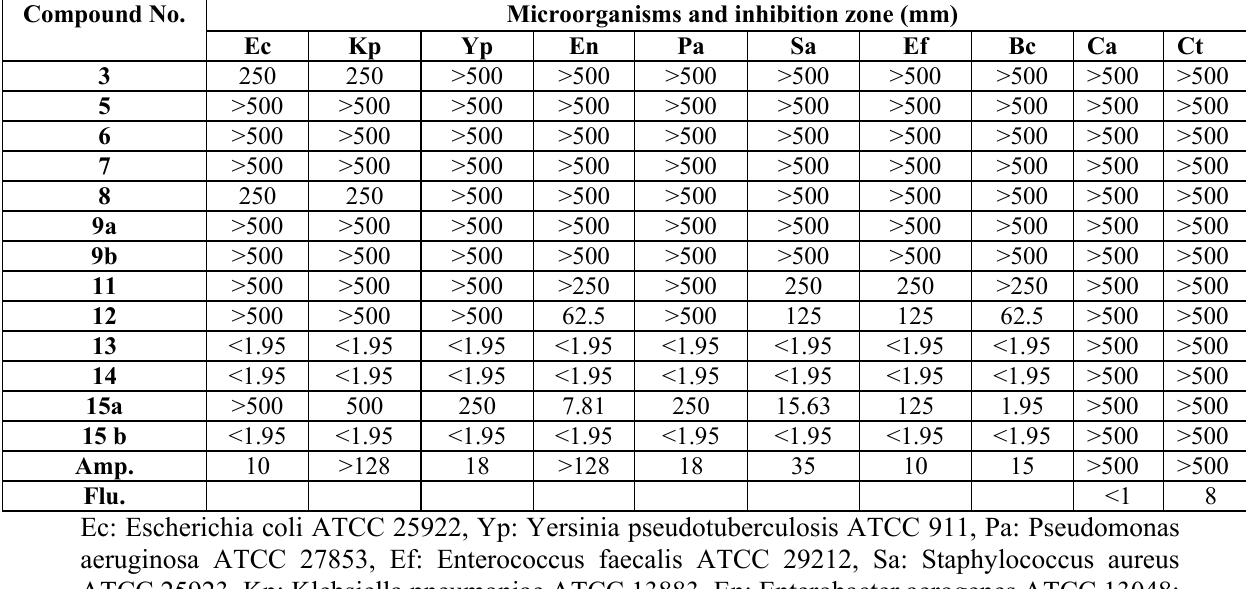
Table 1. Antimicrobial activity of the synthesized compounds